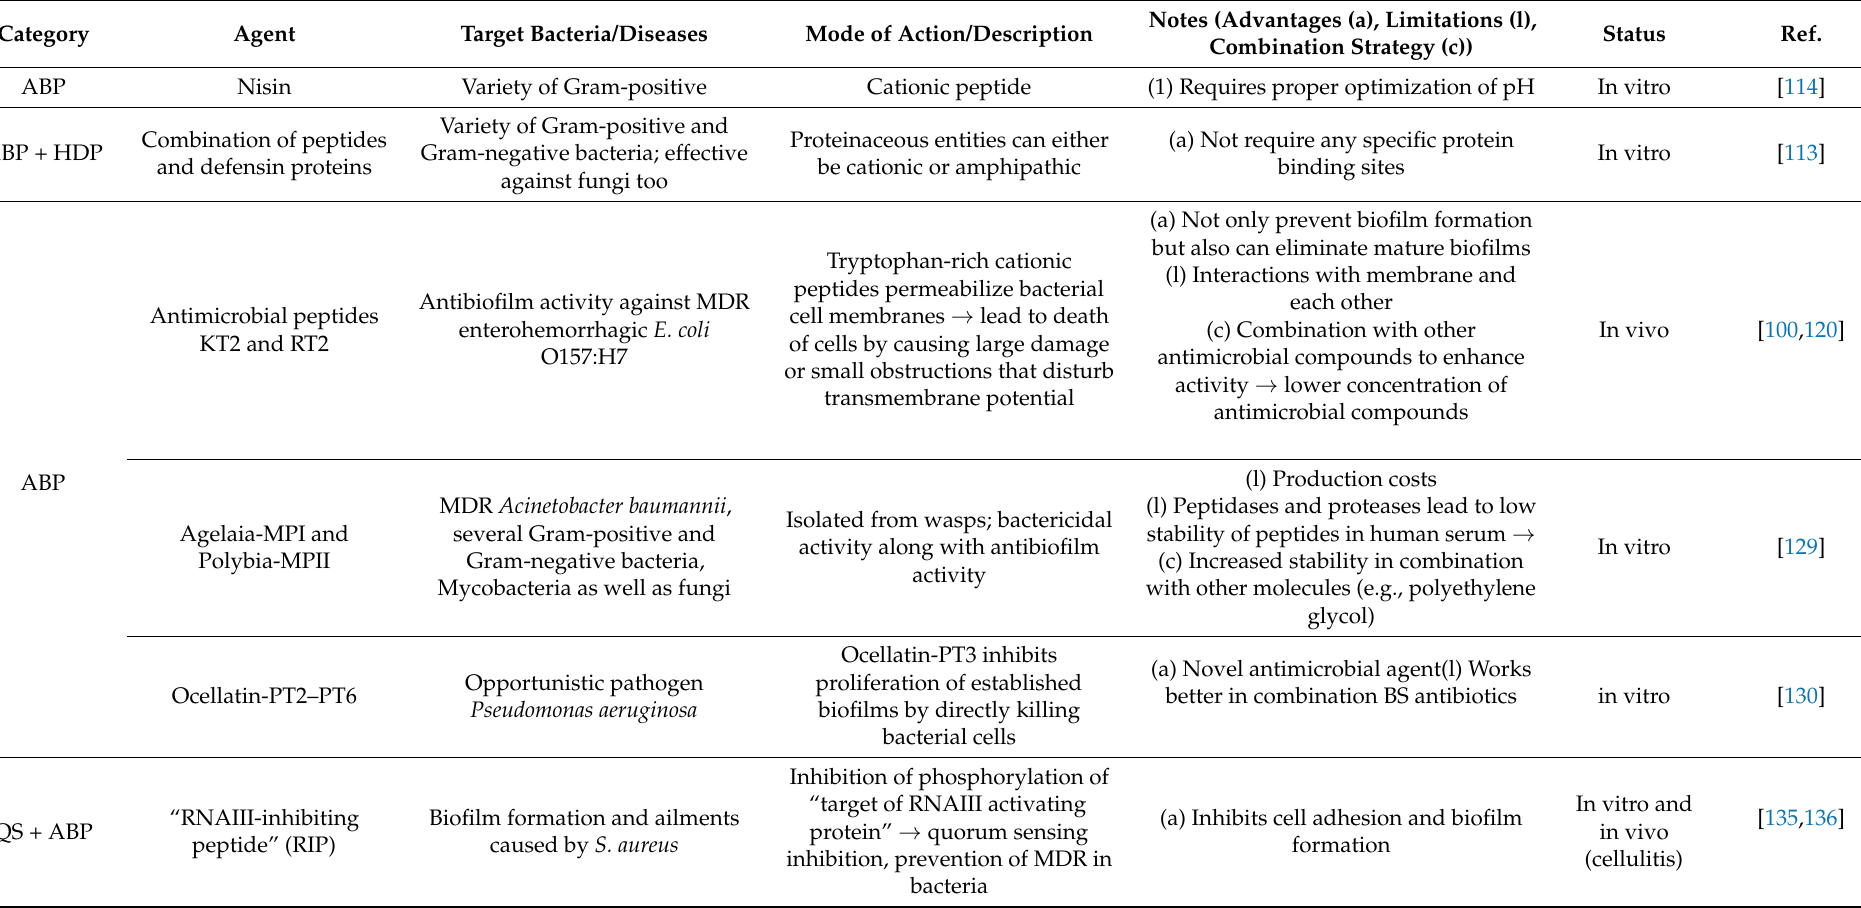
Table 3. A list of different antimicrobial peptides (AMP) (antibiofilm peptides (ABP)) molecules that can be used against multidrug-resistant (pathogenic) bacteria.